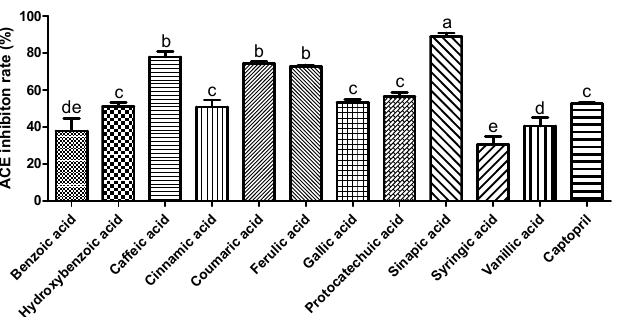
Figure 1. Inhibitory effect of selected phenolic acids (10 mM) on angiotensin I converting enzyme. Captopril (1.15 µ M) was used as positive control. Each value was expressed as the mean ± standard error ( n = 3). Different letters above the bars indicate significant differences based on the Duncan’s test ( p < 0.05).